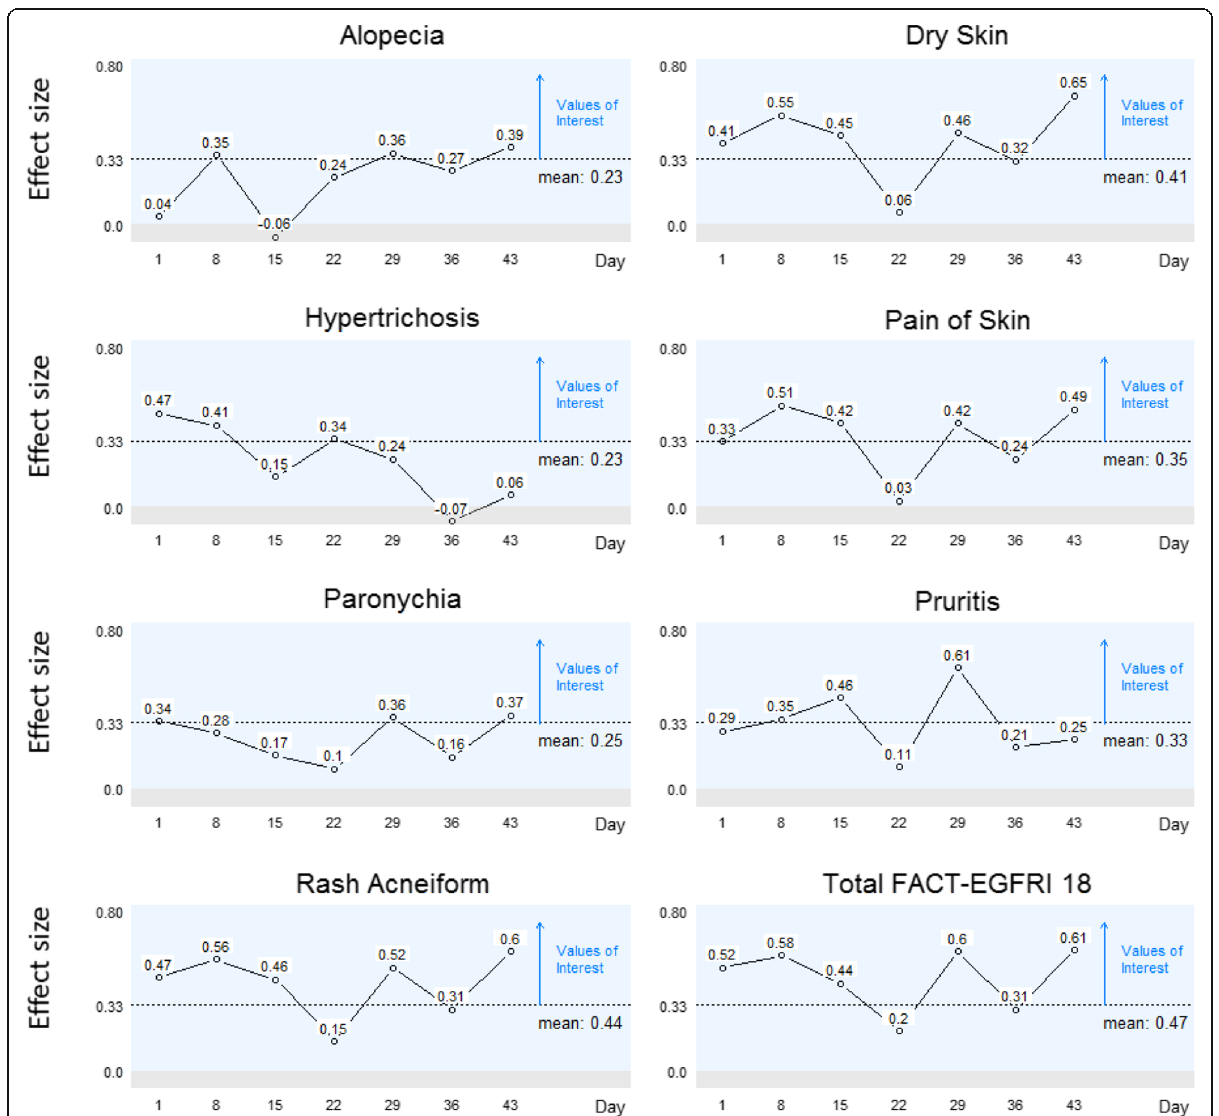
Fig. 3 Standardized Values for Known Groups Validity. Standardized values for known groups validity. Known groups validity was assessed by examining differences in mean EGFRI subscores between patients who reported no symptoms (performance status = 0, n = 31) and any symptoms (performance status > 0, n = 93). ANOVA was used to compare FACT-EGFRI 18 scores between groups, with differences of 1/3 to 1/2 of a standard deviation considered of